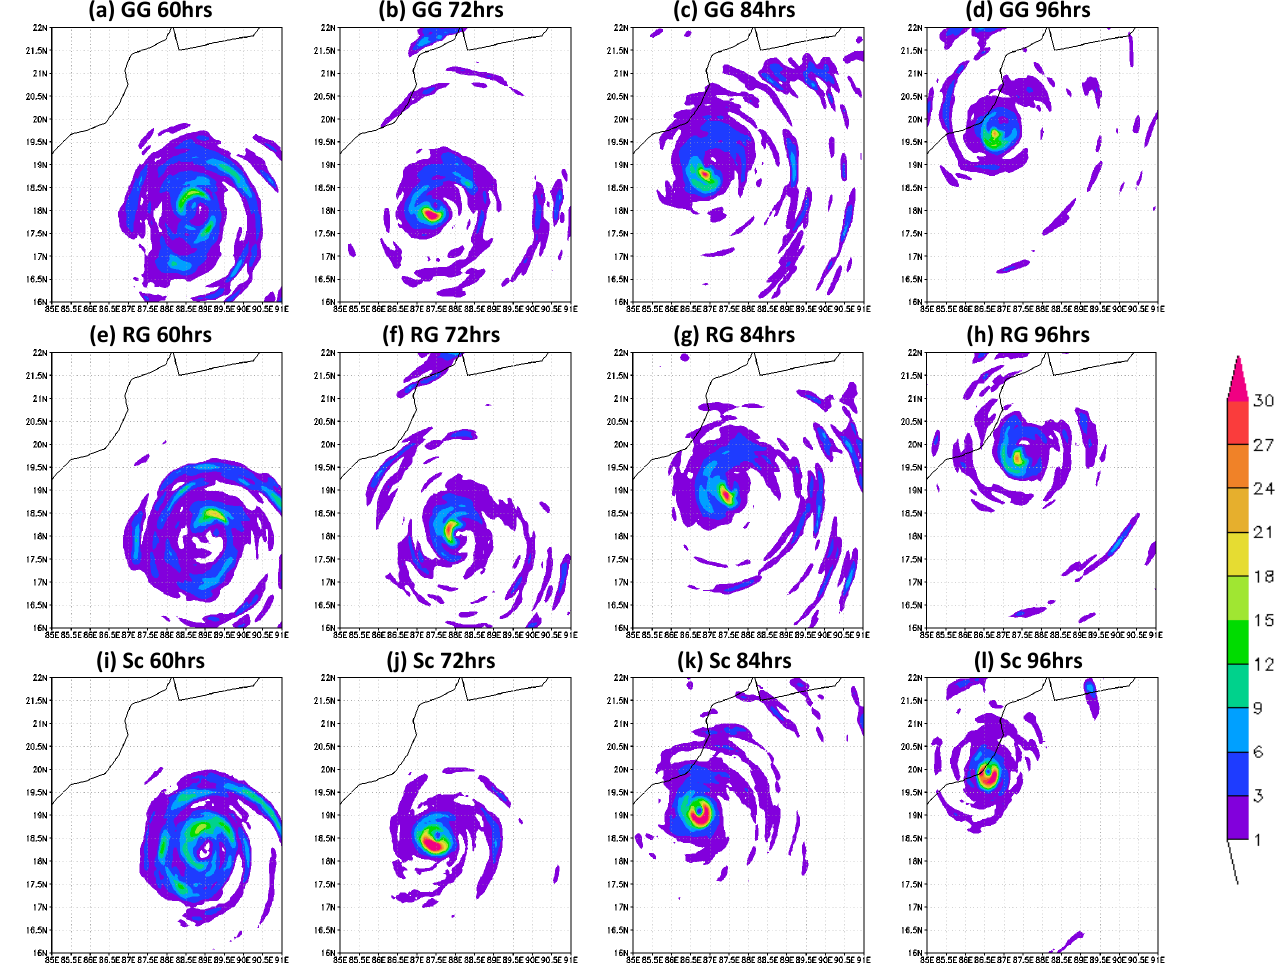
Fig. 12. Same as Fig. 5 but with three MPS, namely GG (a) – (d) , RG (e) – (h) and Sc (i) – (l)